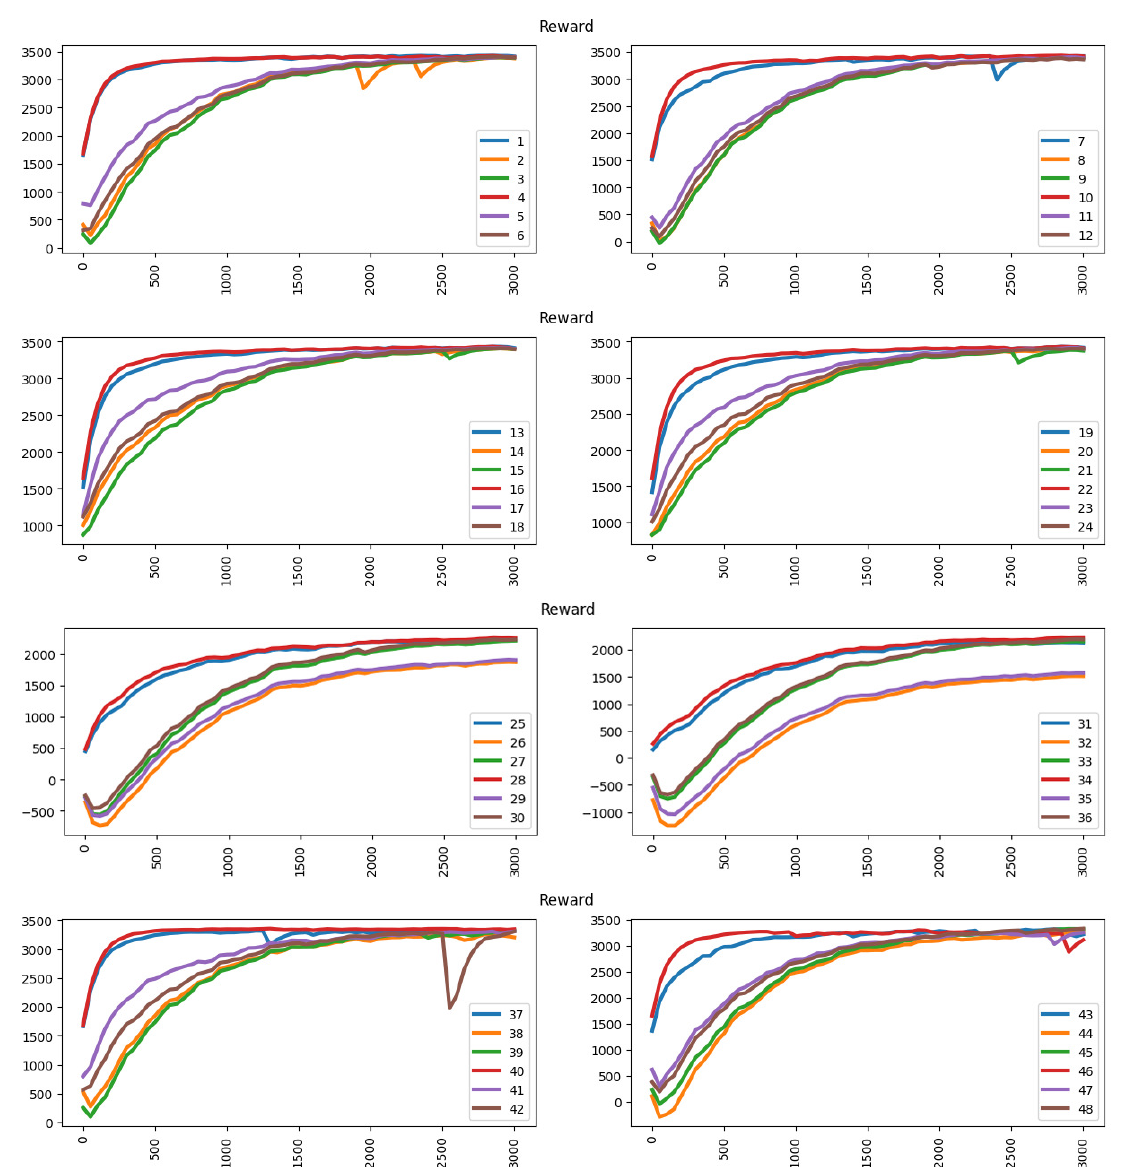
Figure 11. Reward result under the occupancy